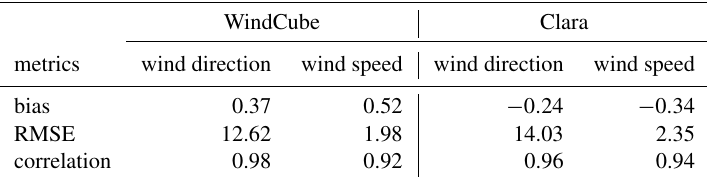
Figure 8. Panel (a) shows the two-dimensional histogram of the wind direction differences (CLARA − WindCube), and panel (b) shows the probability distribution of the differences. The data used in both panels are from the entire CMTRACE campaign. The red dashed line indicates the mean bias for each range interval. Table 6. Statistical metrics of the WindCube and CLARA data assuming the radiosonde measurements as a reference. RMSE stands for root mean square error. The bias and RMSE are in ms − 1 and degrees for the wind speed and wind direction, respectively.